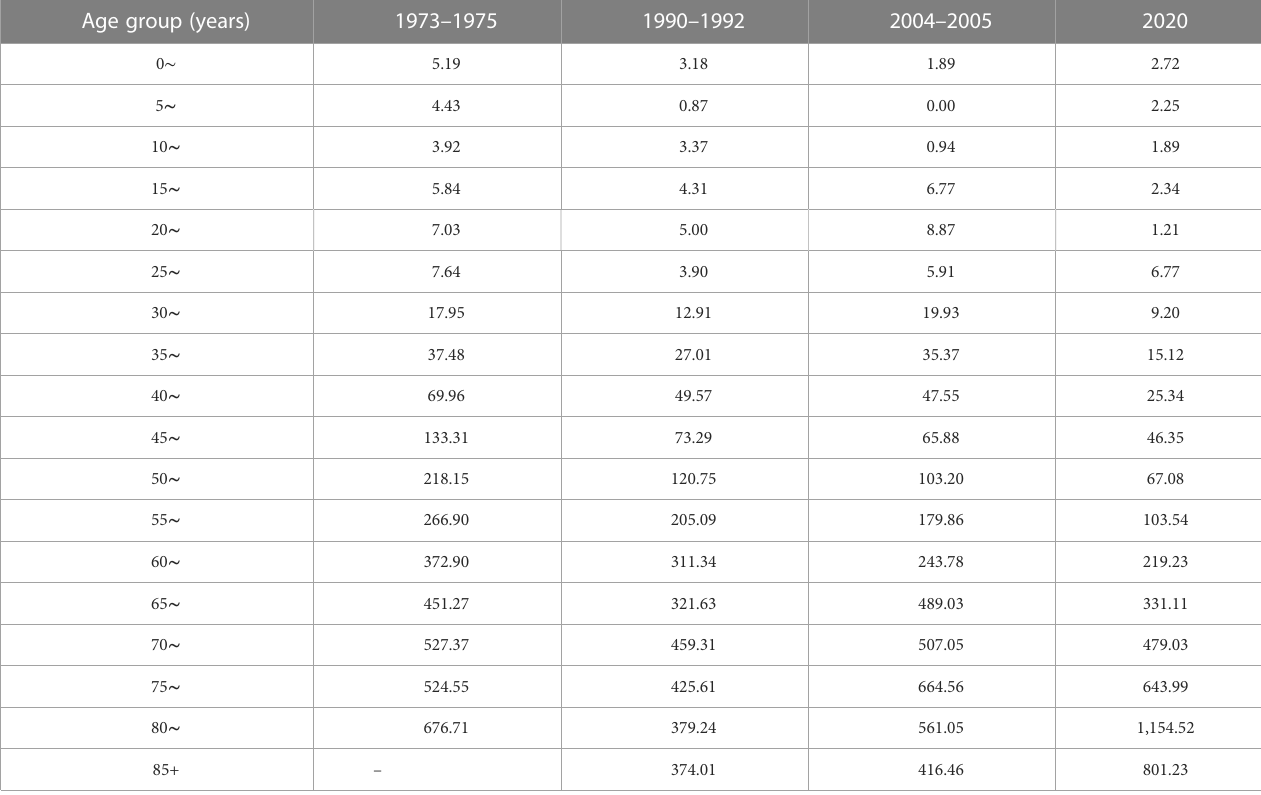
TABLE 3 Age-speci fi c mortality rates of cancer during four periods in female (1/10 5